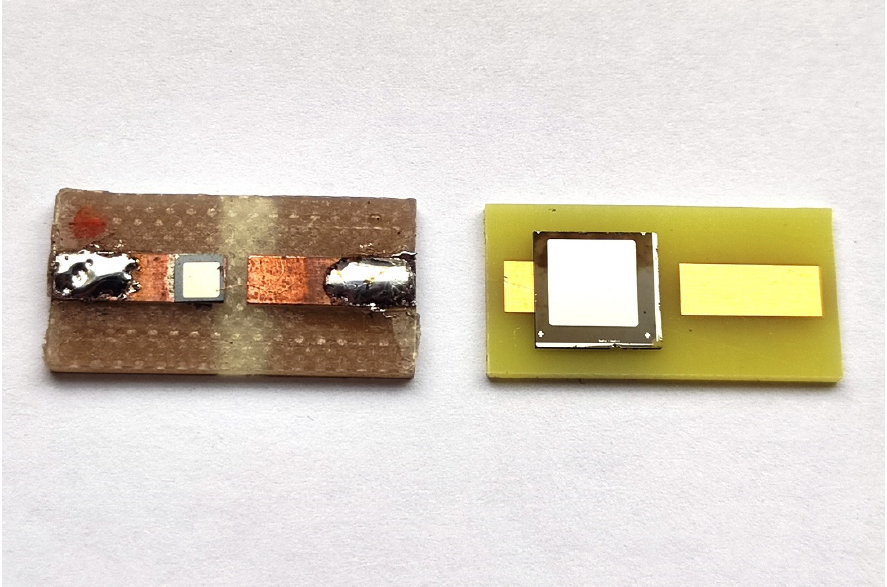
Figure 1. 4H-SiC detectors on chip carriers with different active surface areas: ( left ) 1 mm × 1 mm and ( right ) 5 mm × 5 mm.